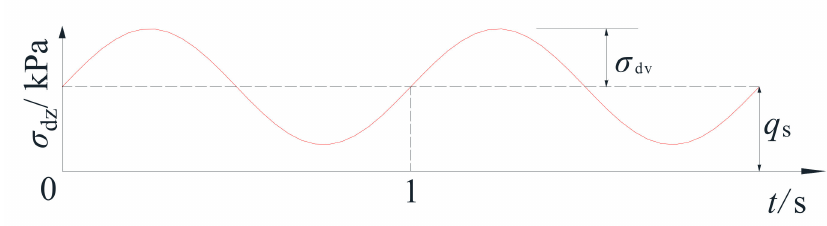
Figure 5. Schematic diagram of vertical cyclic